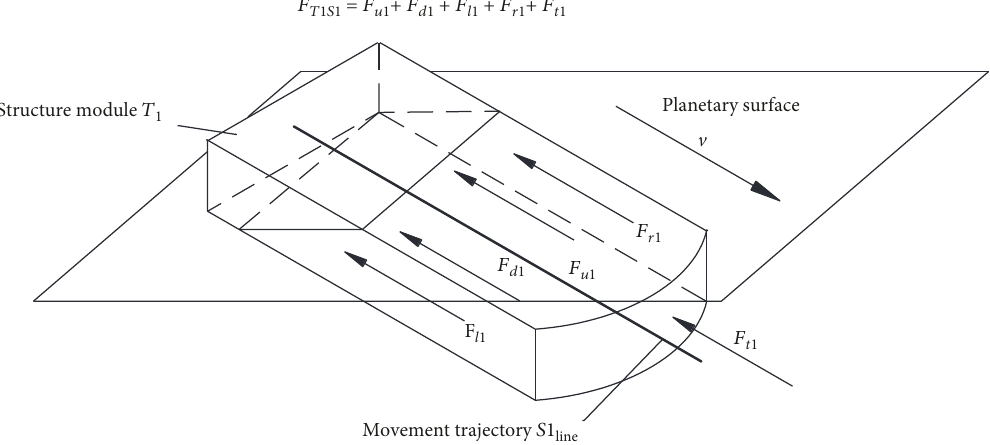
S 1 1 in stage line